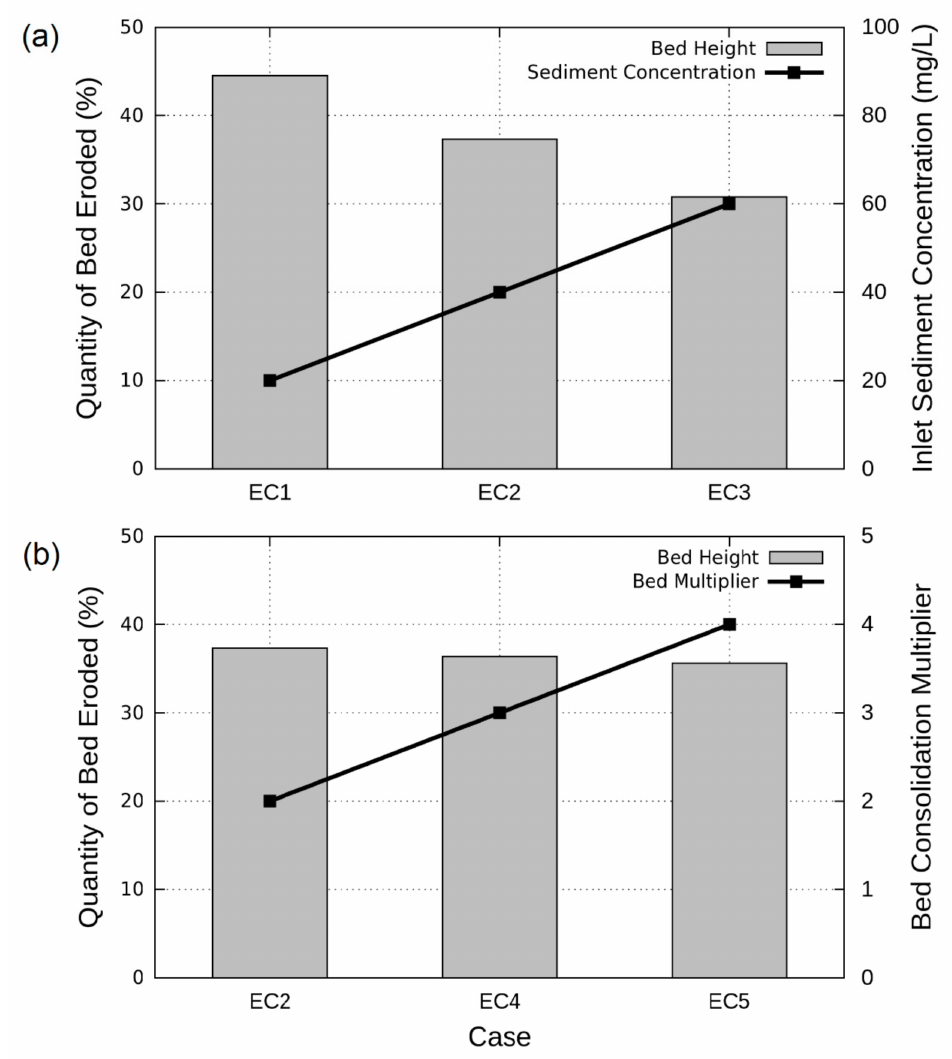
Figure 9. Quantity of bed eroded at the end of the ( a ) EC1, EC2, and EC3 simulations and the inlet Type E sediment concentrations used in the simulations and ( b ) EC2, EC4, and EC5 simulations and the bed consolidation multiplier, the magnitude of increase between the reference, and the calculated critical Shields stress, i.e. θ Cmax / θ Co,i , used in the